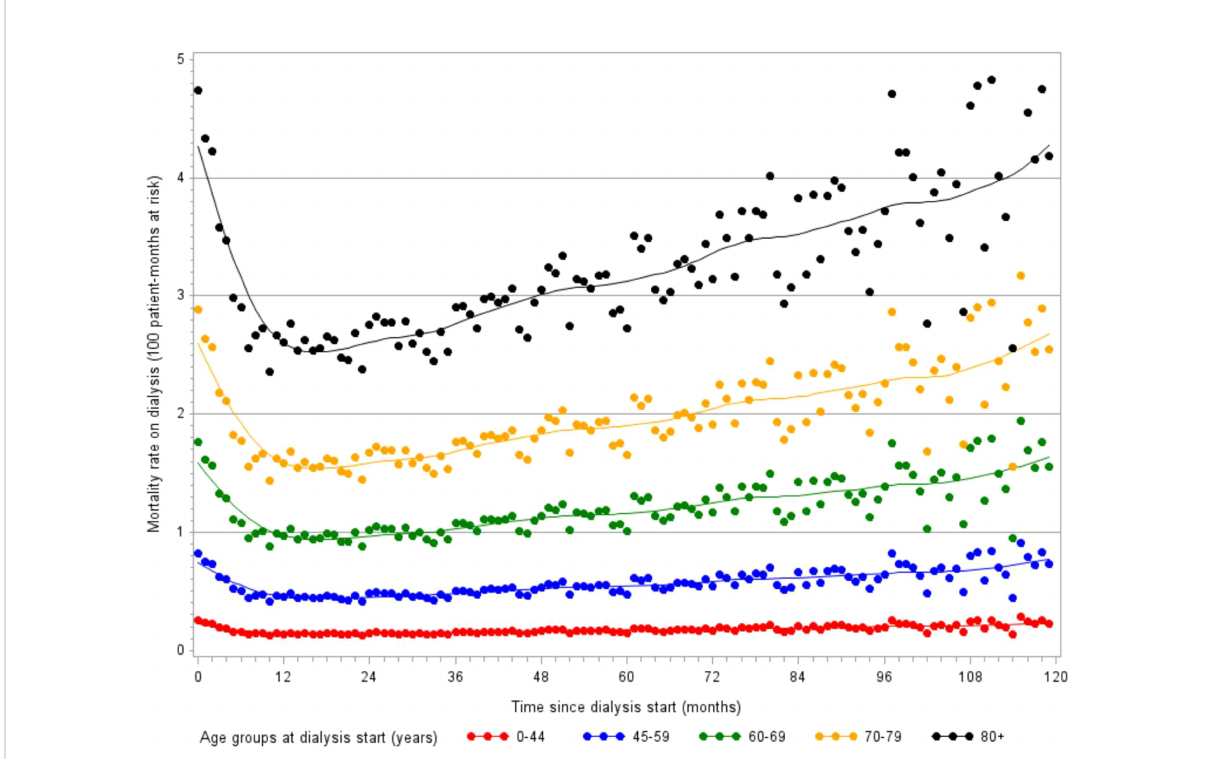
FIGURE 5 Evolution of monthly mortality rates over 10 years following dialysis initiation, strati fi ed by age (monthly incidence estimated with a Poisson model, source REIN